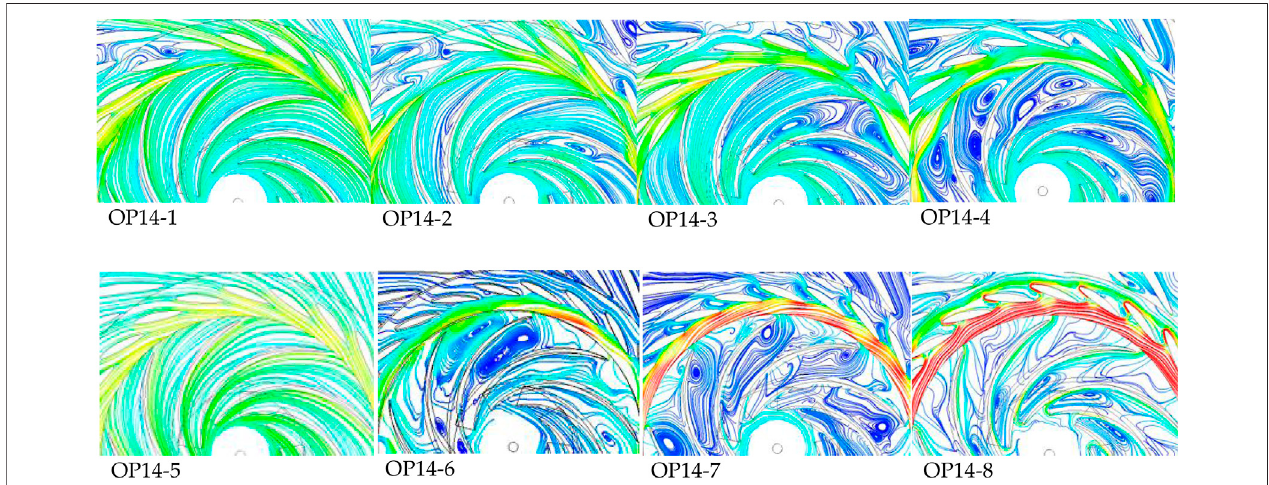
FIGURE 3 | Streamlines of runner and vanes at Span = 0.50.